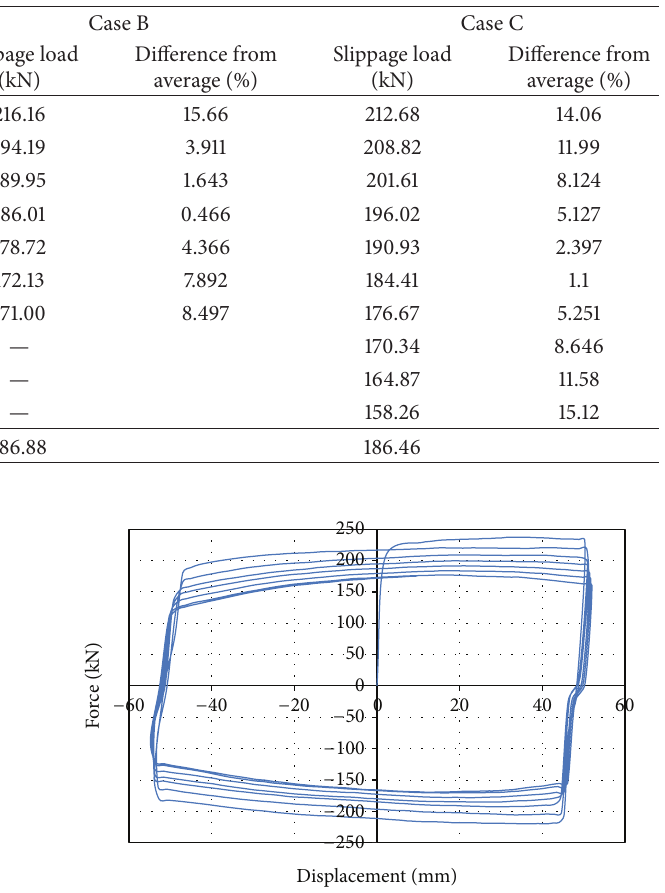
Figure 5: Experimental hysteretic force-displacement curve of the original CFD (case